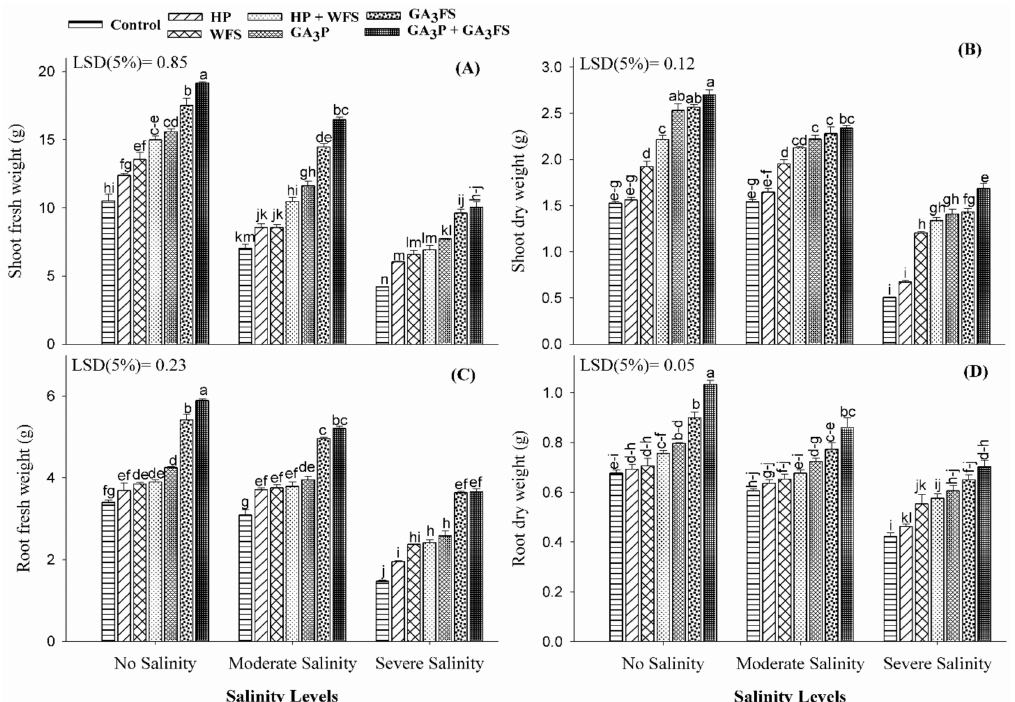
Figure 1. Shoot fresh weight ( A ), shoot dry weight ( B ), root fresh weight ( C ) and root dry weight ( D ) of maize as affected by different treatments of gibberellic acid under no salinity (control), moderate salinity (6 dS m − 1 ), and severe salinity (12 dS m − 1 ). Values are means ± SD (n = 3). Hydropriming (HP); water foliar spray (WFS); hydropriming and water foliar spray (HP + WFS); seed priming with GA 3 (GA 3 P); foliar spray with GA 3 (GA 3 FS); seed priming and foliar spray of GA 3 (GA 3 P + GA 3 FS). Bars with the same letters do not differ significantly at p ≤